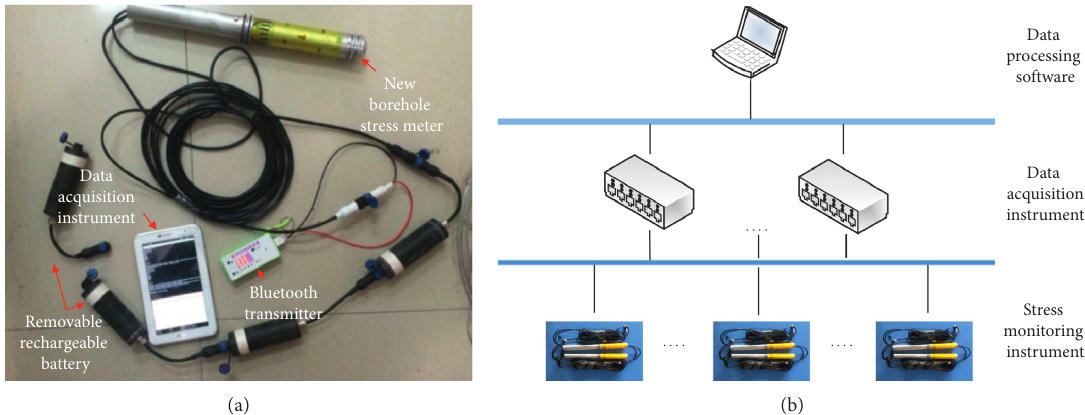
Figure 1: Mining stress monitoring